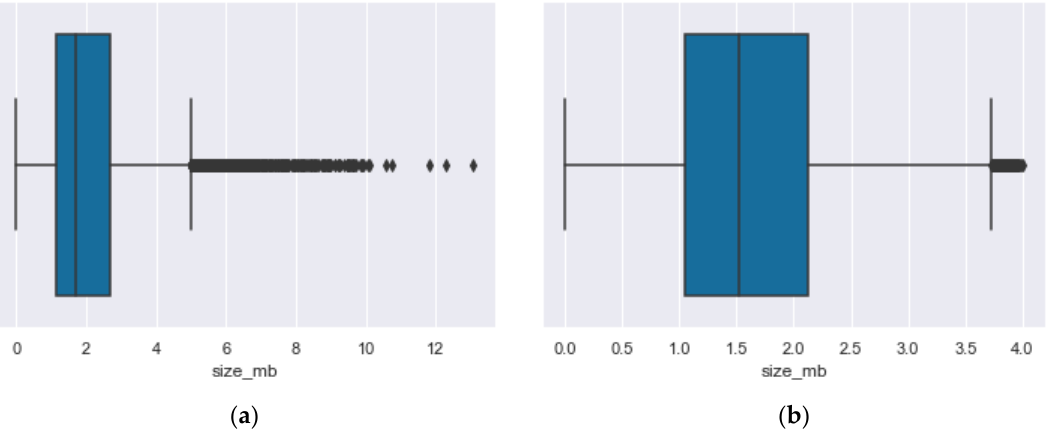
Figure 3. This visualization of removing outliers from the dataset: ( a ) 4-ways of wearing masks; ( b ) 3-ways of wearing masks.